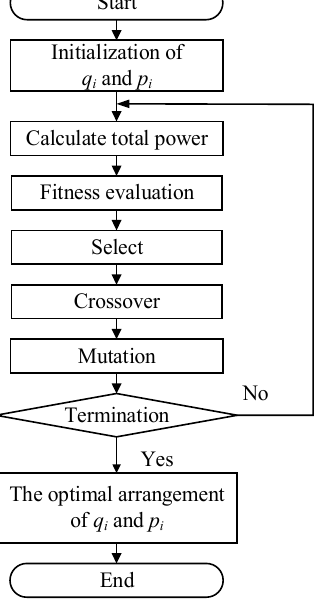
Figure 6. Optimization process of genetic algorithm.